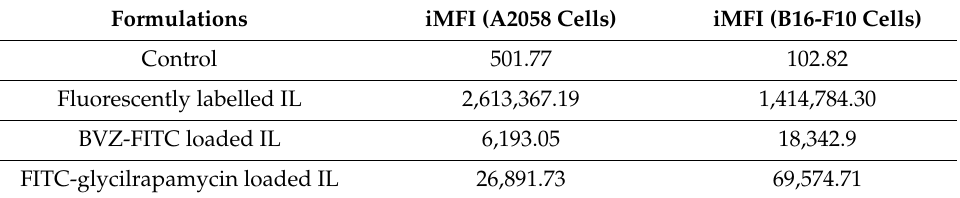
Table 2. iMFI calculated through flow cytometry. IL: Intralipid ® ; FITC: fluorescein isotiocyanate;